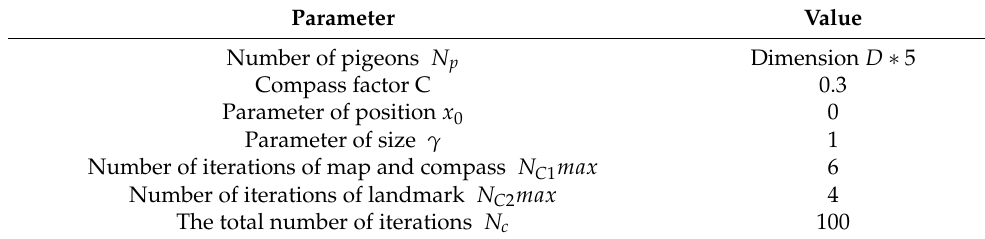
Table 2. Experimental